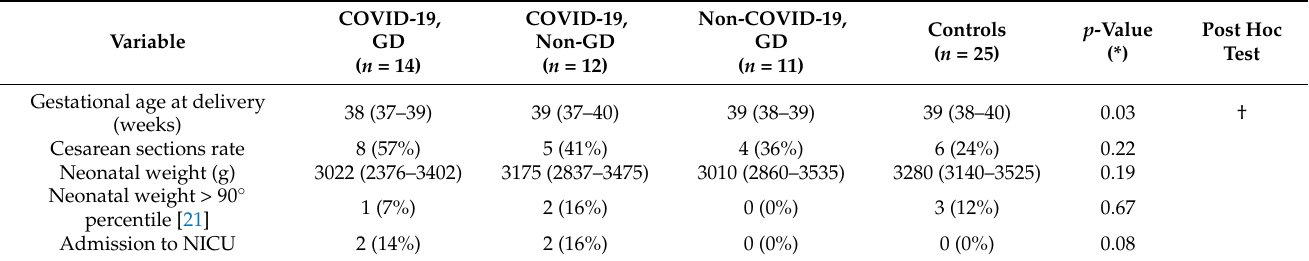
Table 2. Mode of delivery and neonatal outcomes.